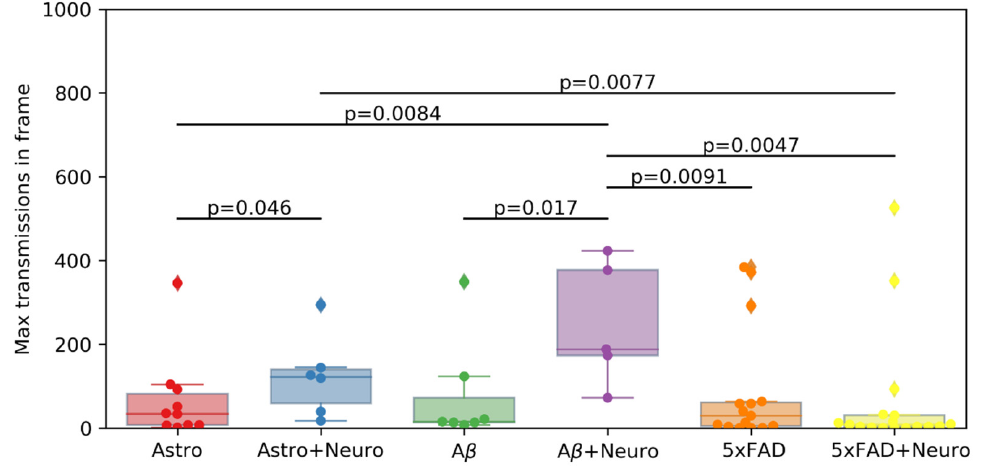
Figure 9. Comparison of the maximum number of calcium signal transmissions in a frame. The significance of differences between groups was assessed using a Mann–Whitney–Wilcoxon test.